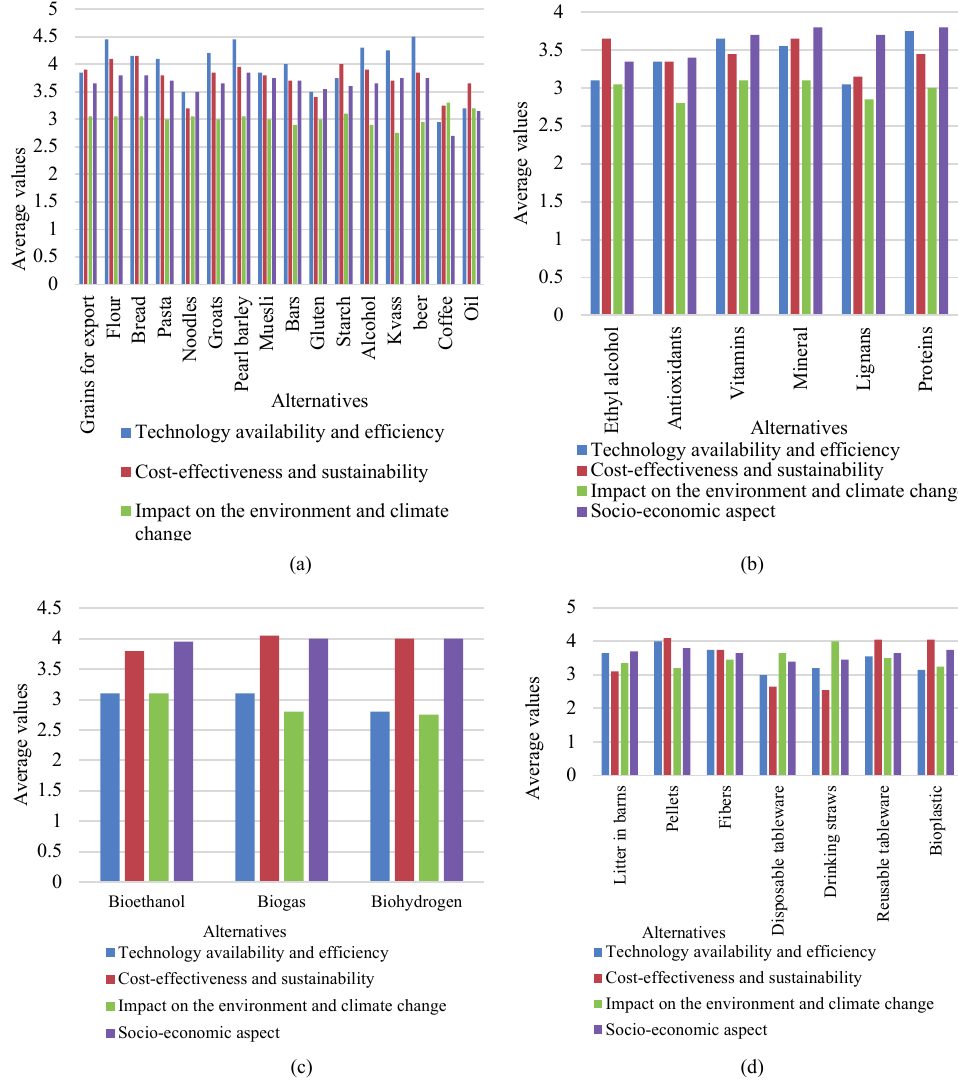
Fig. 5. Average rating of respondents for the groups of: a) food; b) pharmaceutical; c) straw products and d) the transport sector. According to data in Fig.